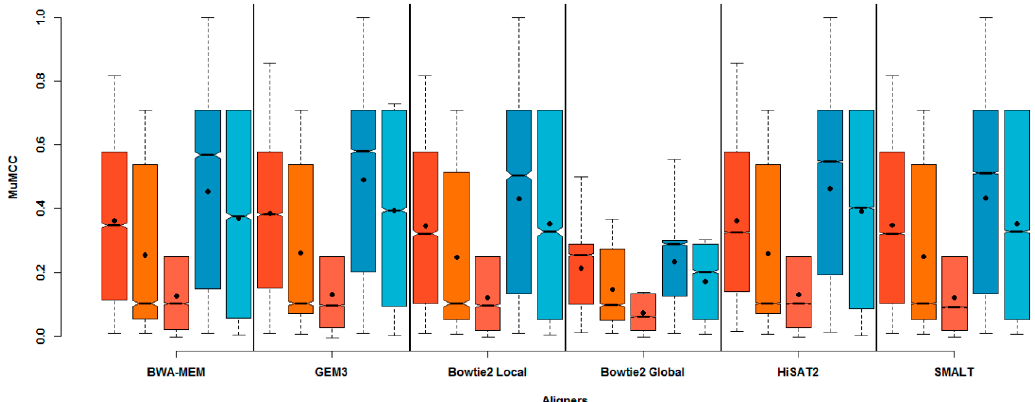
Figure 2. The effect of short read aligner choice on SNV calling accuracy. The range of micro-averaged Matthews correlation coefficient (MuMCC) scores of each of the tested aligners (including all parameters) used for all singlet population types. The mean of the MuMCC range is indicated by the solid black dot within each boxplot. Minimum and maximum whiskers on each bar plot indicate the highest and lowest MuMCC scores. RNA High = Red, RNA Medium = Orange, RNA Low = Light orange, DNA High = Blue, DNA Low = Light blue.